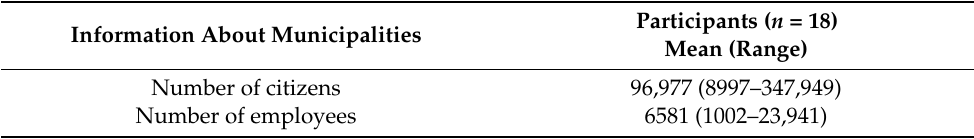
Table A1. Number of citizens and number of municipal employees in participating